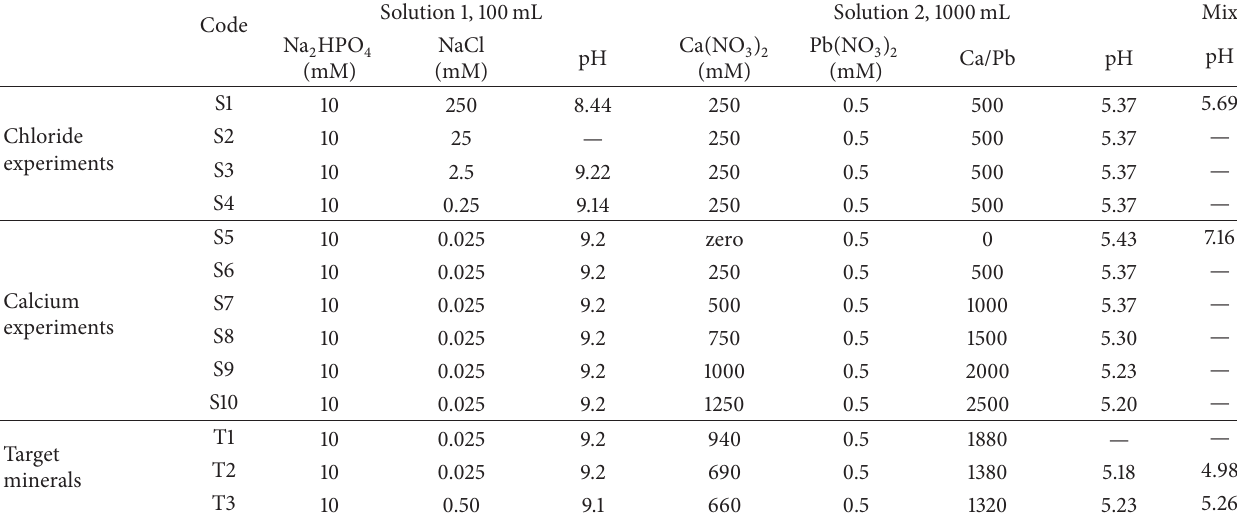
Table 1: Composition of solutions 1 and 2 used to make the synthetic calcium lead apatites, S1–S10 and